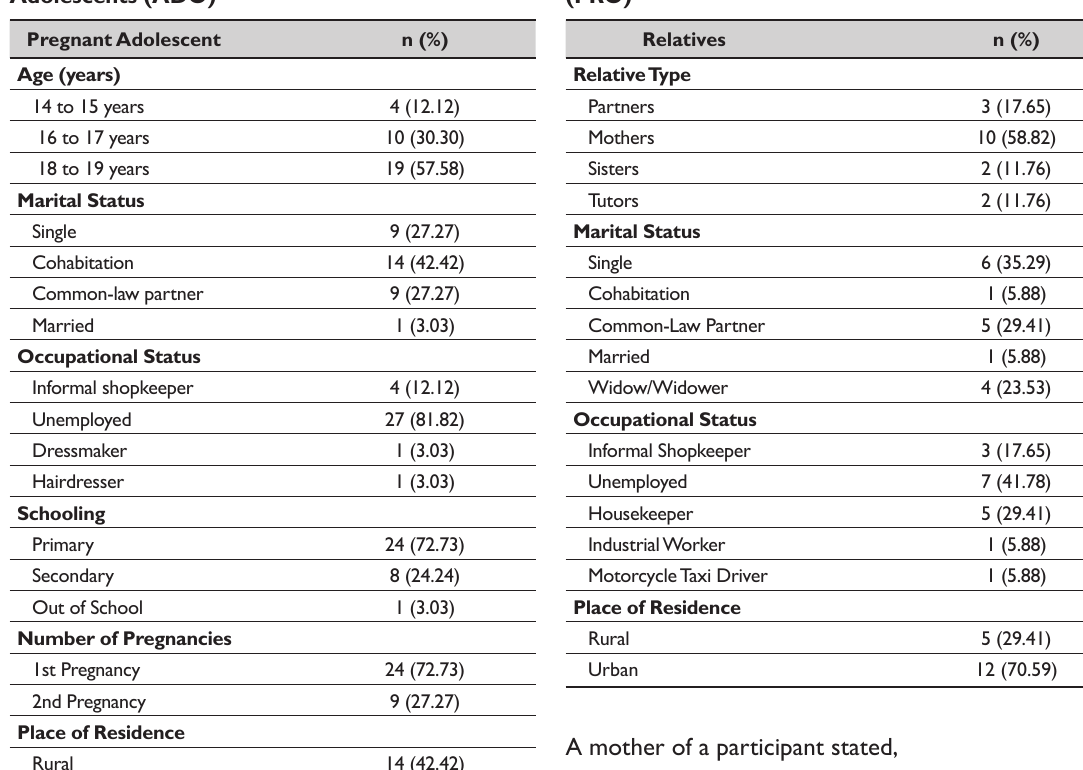
Table 1: Demographic Characteristics of Pregnant Table 2: Demographic Characteristics of